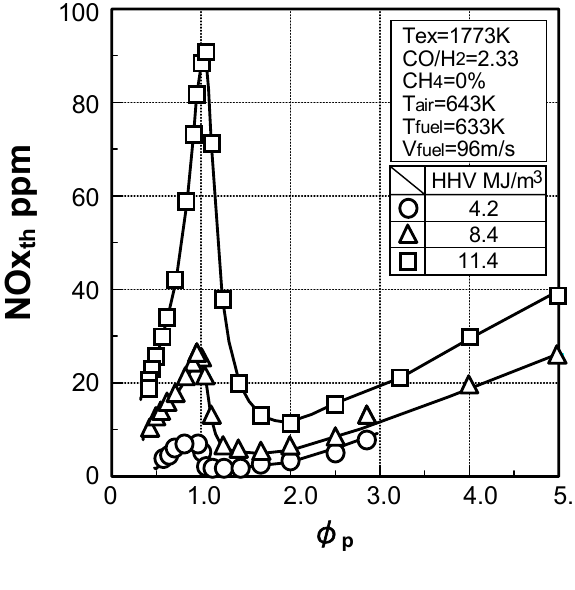
Figure 24. Influence of fuel calorific value on relation between the primary-equivalence ratio and thermal-NOx emissions in two-stage